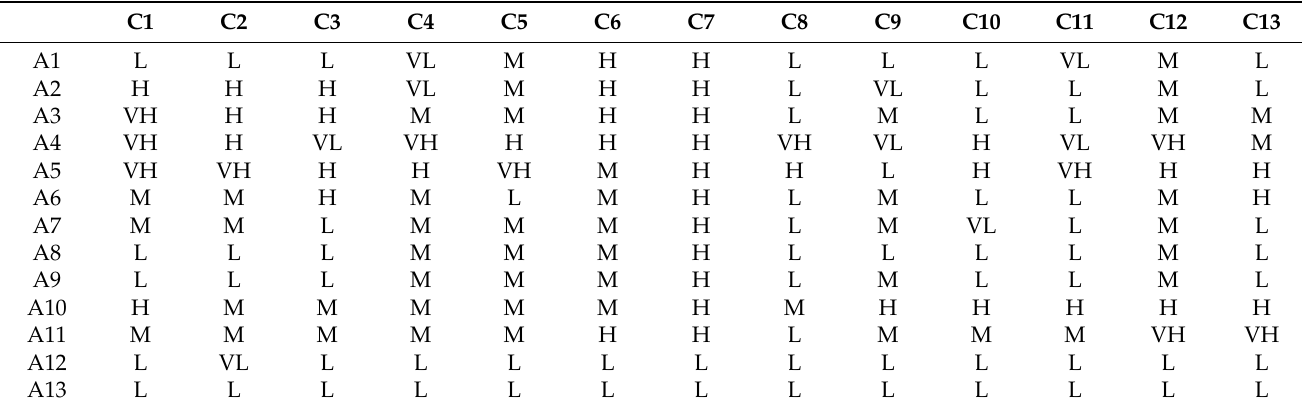
Table A6. Decision maker 4 (cid:48) s linguistic assessment.